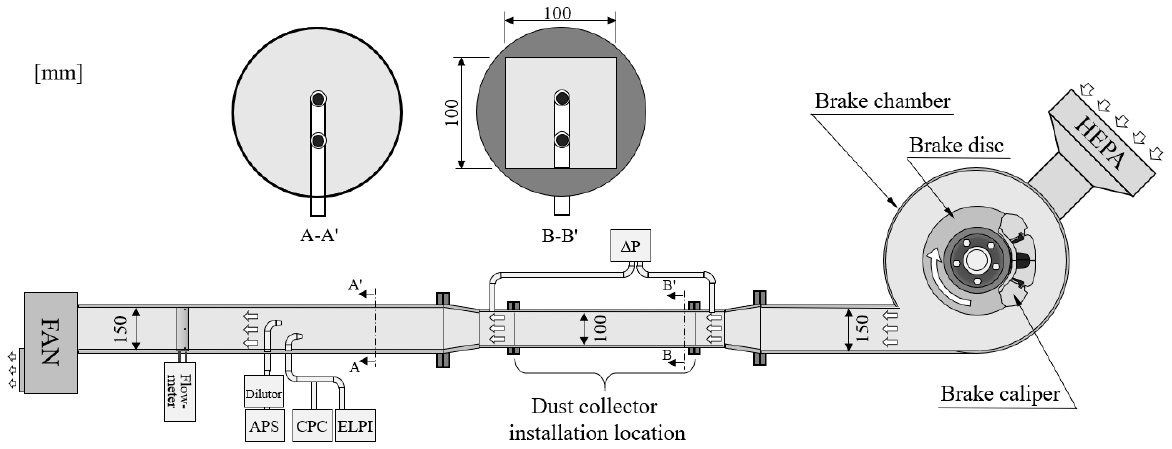
Figure 2. Schematic of brake dynamometer and dust collector (inertial separator, ESP, or hybrid precipitator) test